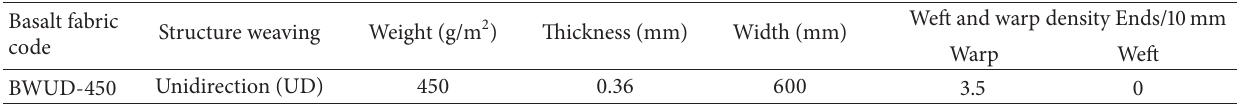
Table 4: Basalt unidirectional fabric specifications.